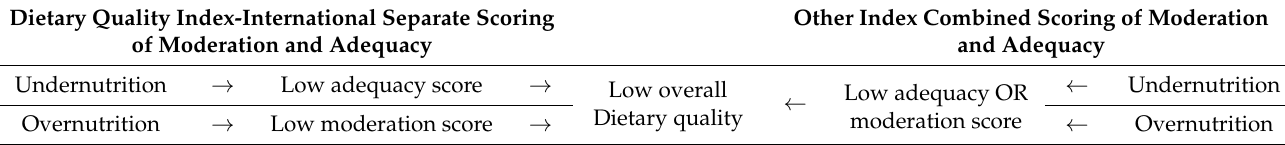
Table 1. Comparison of Index Scoring Components: Adequacy and Moderation.